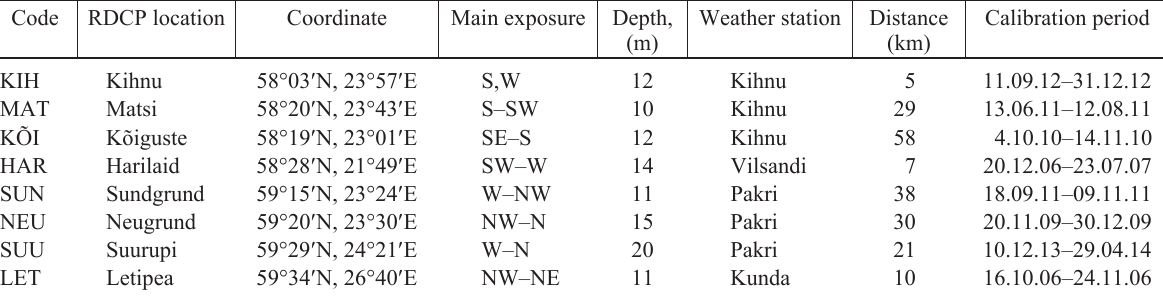
Fig. 1. Map of the study area. Wave measurement and modelling locations are denoted with codes (see Table 1). The locations of the weather stations used in calibrations or hindcasts are marked with  . Table 1. Wave model calibration results in different locations (Fig. 1). Wave modelling was performed at the ‘RDCP location’ with given coordinates, exposure and depth. Weather stations and their corresponding distances to the RDCP and the data intervals used for calibration are